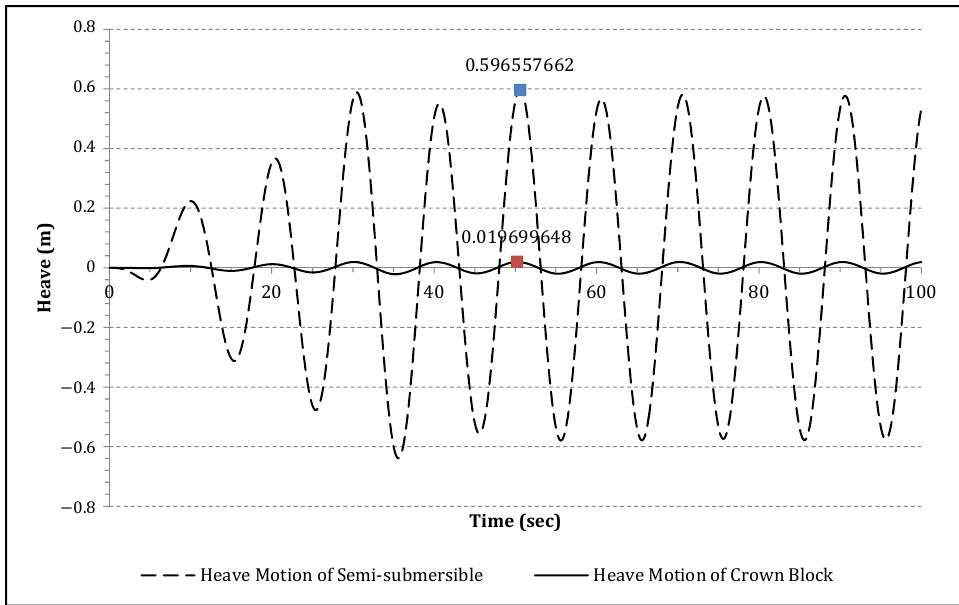
Figure 15. Dynamic response analyses of the semi-submersible and crown block with the heave compensation system for a 4-m wave amplitude.